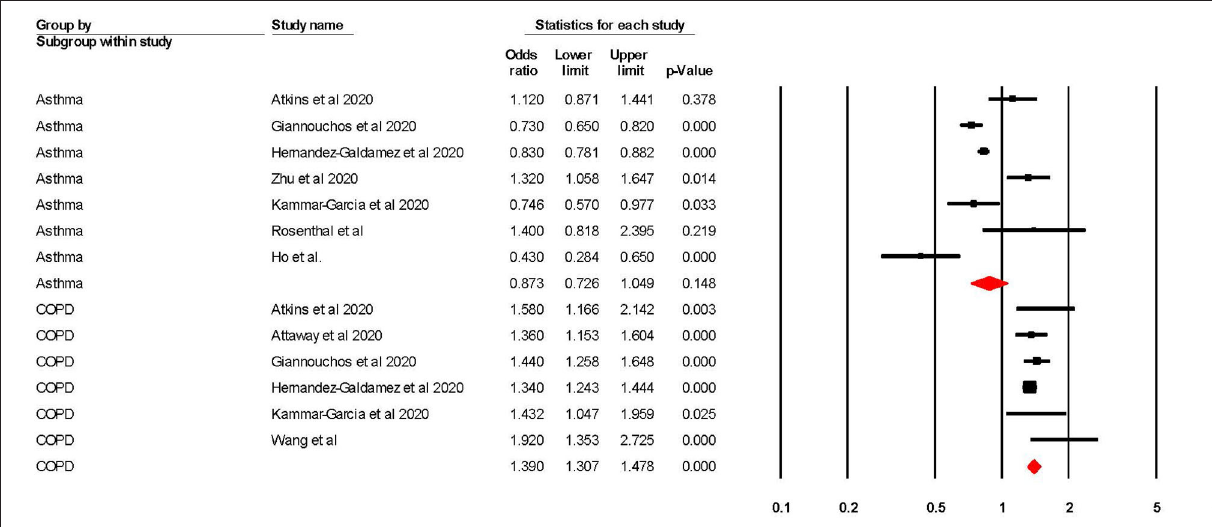
FIGURE 2 | Forest plot showing odds ratios (adjusted for at least one confounder) for COVID-19 related hospitalisation in subjects with asthma or Chronic Obstructive Pulmonary Disease